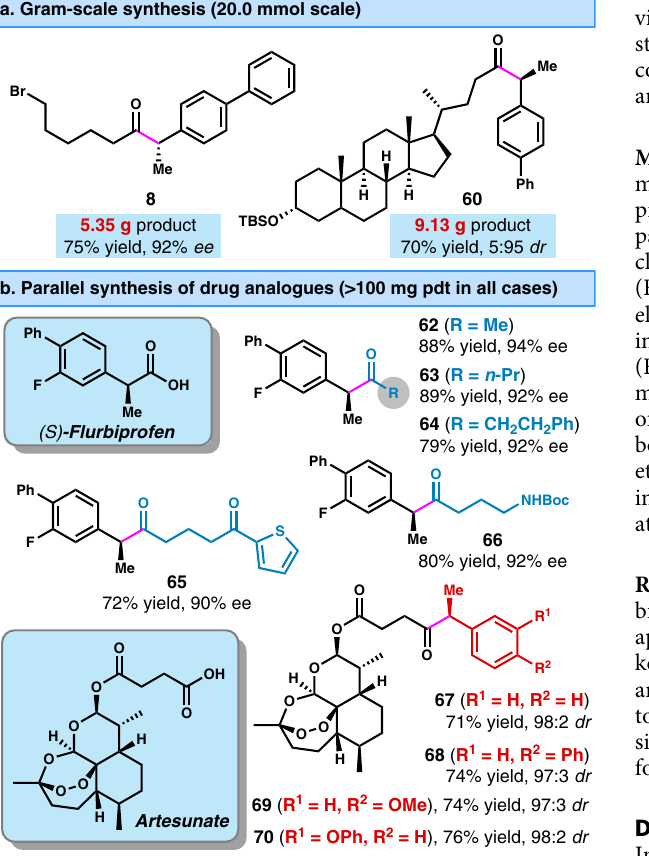
b. Parallel synthesis of drug analogues (>100 mg pdt in all